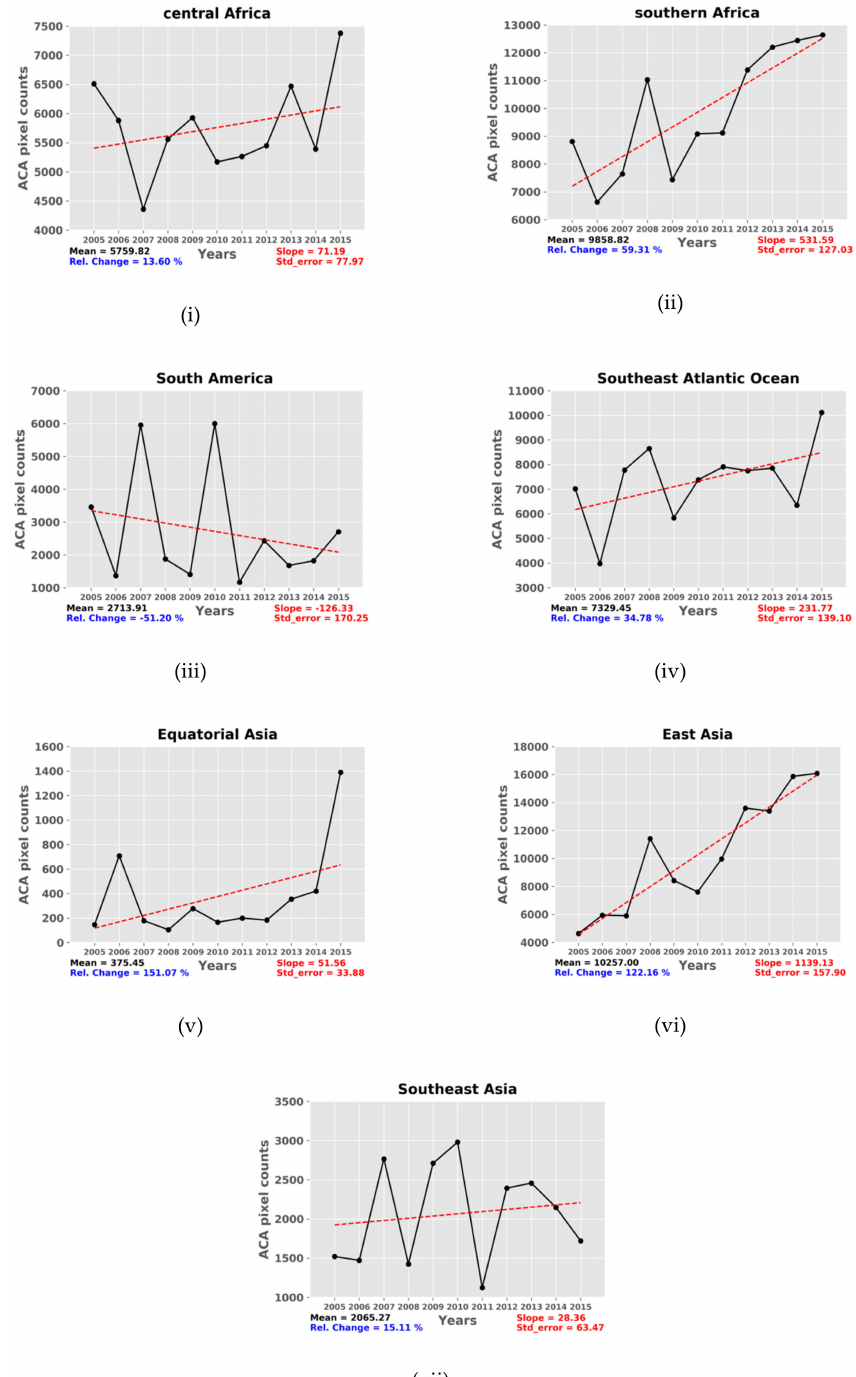
Figure 7. Interannual variability (2005–2015)and linear trend of: the frequency of absorbing carbonaceous aerosols (ACA, in terms of total absolute number of grid cells (1 ◦ × 1 ◦ ) per year over which ACA have been detected by the satellite algorithm). Results are given for: ( i ) Central Africa, ( ii ) Southern Africa, ( iii ) South America, ( iv ) Southeast Atlantic Ocean, ( v ) Equatorial Asia, ( vi ) East Asia and ( vii ) Southeast Asia. In each case, linear regression is applied to the time-series and the computed slope and associated standard error values are given (red colored text) at the right bottom of each panel. The estimated 2005–2015 mean values and relative percent changes are also given (black and blue colored text, respectively) at the left bottom of each